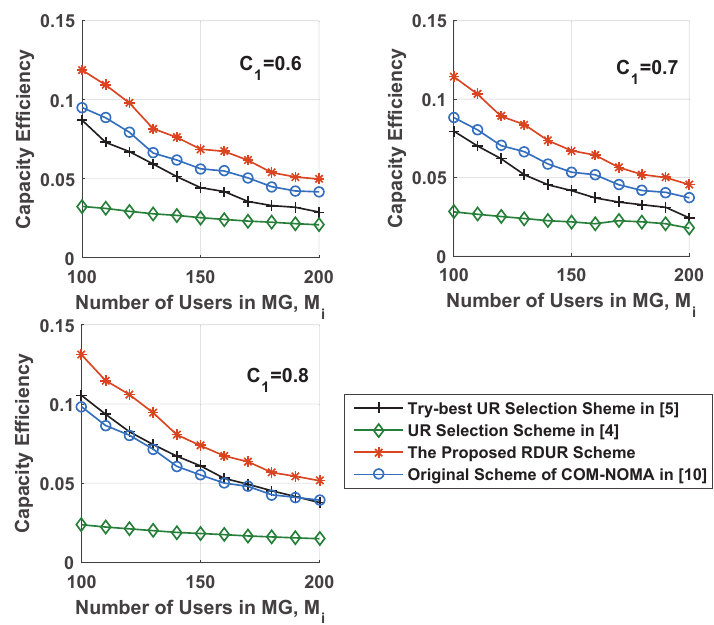
Figure 8. Capacity efficiency versus the number of users in MG, in different C 1